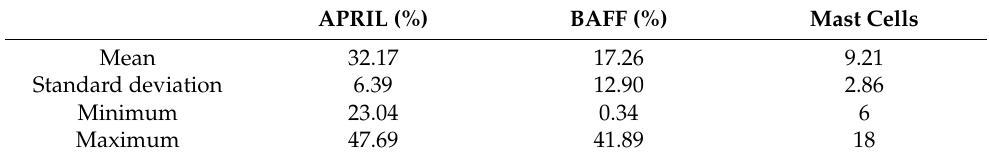
Table 3. Quantification of APRIL, BAFF, mast cells, in peri-implant soft tissue with peri-implantitis. APRIL (%) BAFF (%) Mast Cells Mean 32.17